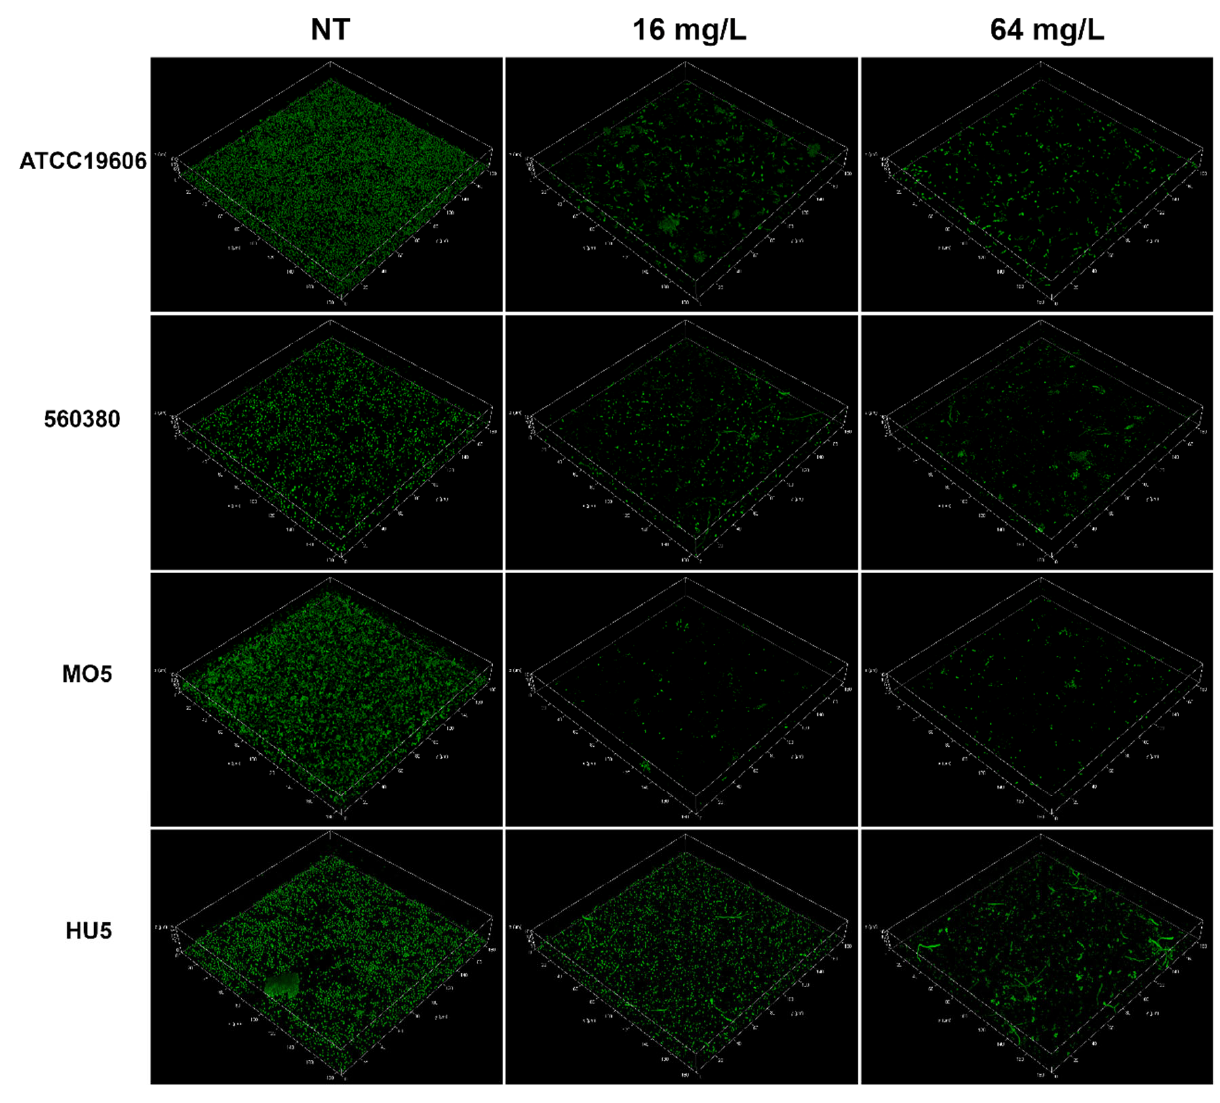
Figure 4. CLSM images of A. baumannii biofilms grown in four-well chambered coverslips. Pictures were taken with an overall magnification of 400 × . Cells were grown overnight at 37 ◦ C in MH with no C109 (NT), 16 mg/L of C109 or 64 mg/L of C109. Seventy planes at equal distances along the Z -axis of the biofilm were imaged by CLSM. 2D images were stacked to reconstruct the 3D biofilm image. Scale bar represents 28 μ m.